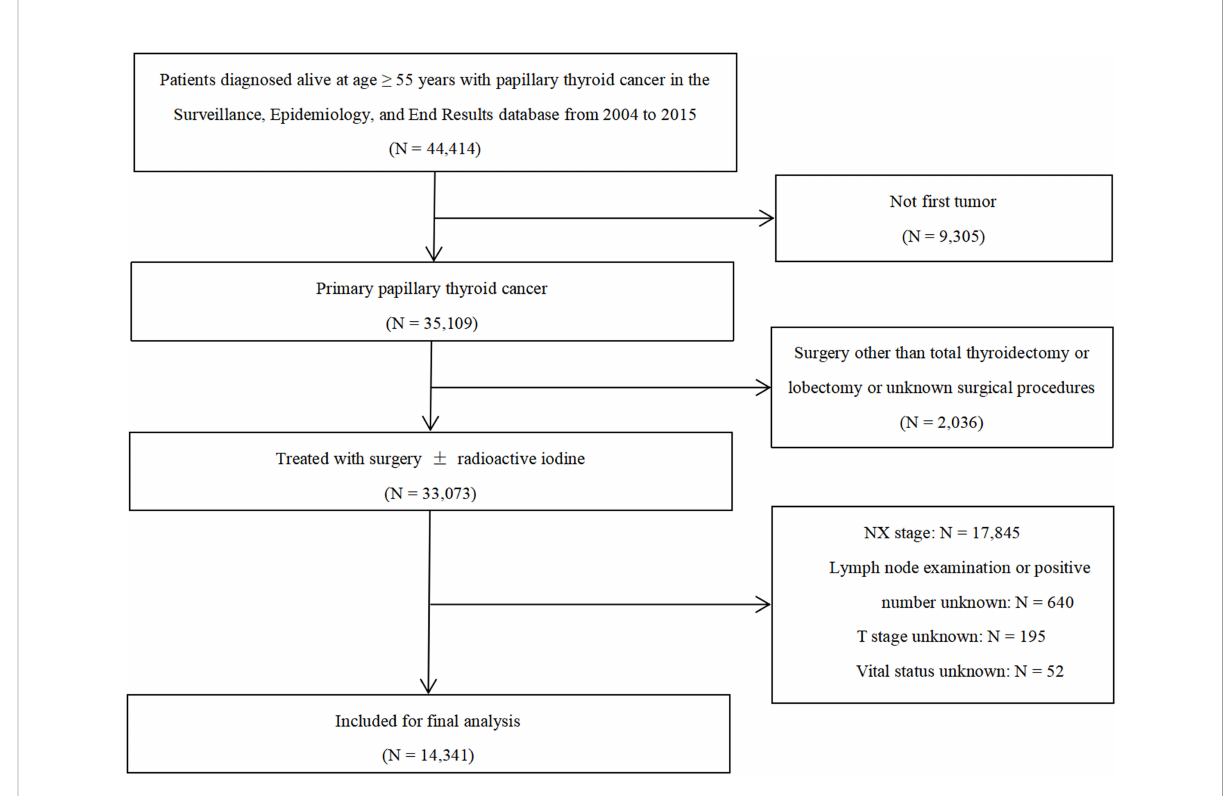
FIGURE 1 Flow chart of the study